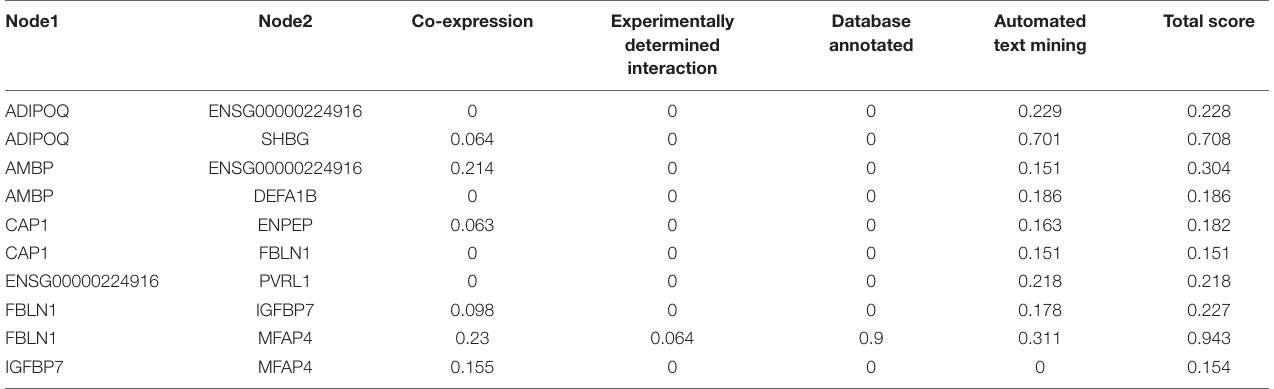
TABLE 5 | Comprehensive score of interactions between differential expressed peptides. Node1 Node2 Co-expression Experimentally